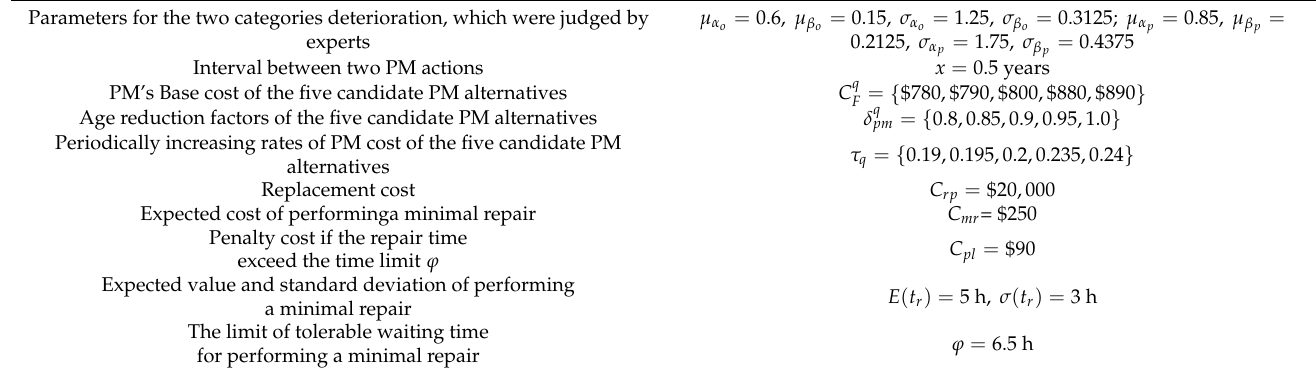
Table 2. The detailed information of all candidate PM